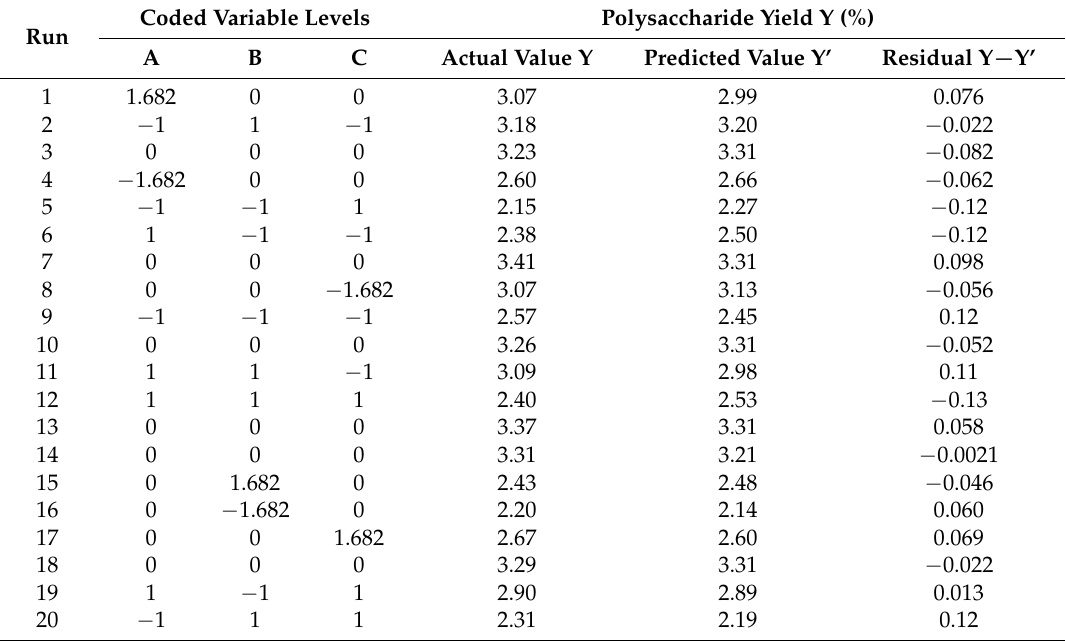
Table 1. The experimental design and results of the central composite design (CCD).